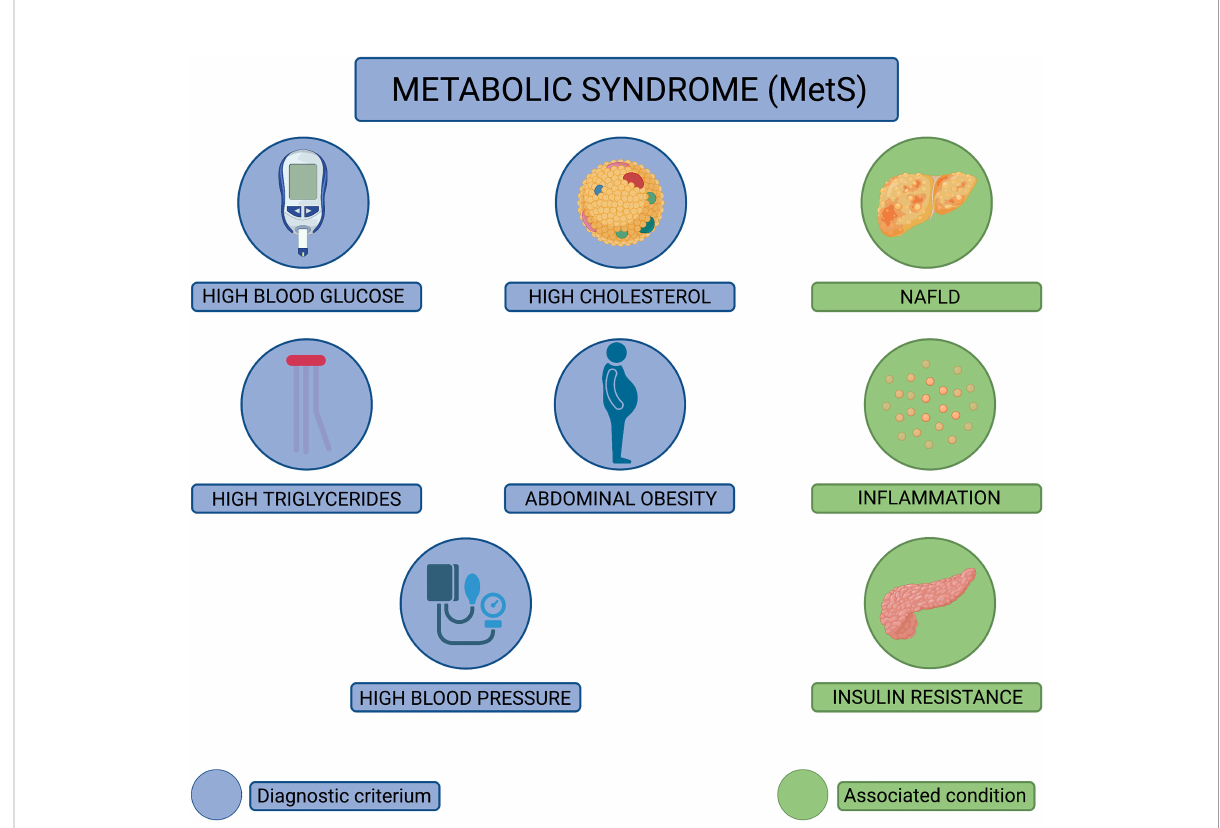
FIGURE 1 Diagnostic criteria for metabolic syndrome (MetS). Pictorial representation of the diagnostic criteria used to diagnose metabolic syndrome (MetS). MetS is diagnosed when an individual displays at least three of the following pathophysiological conditions: high blood glucose, high cholesterol, high triglycerides, abdominal obesity, and high blood pressure (conditions depicted in blue). In addition to these conditions, MetS patients often experience nonalcoholic fatty liver disease (NAFLD), chronic in fl ammation, and insulin resistance (conditions depicted in